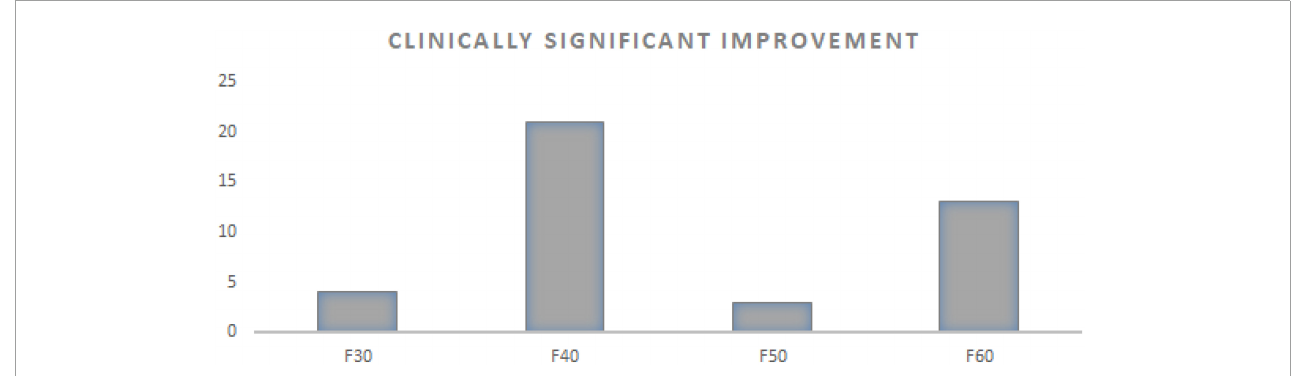
FIGURE2 Number of patients with clinically significant improvement in relation to ICD diagnosis (total number 41/71 patients). F30 F30-F39-mood affective disorders (total number 8). F40 F40-F49-anxiety, dissociative, stress-related, somatoform, and other non-psychotic mental disorders (total number 37). F50 F50-F59-behavioral syndromes associated with physiological disturbances and physical factors (total number 6). F60 F60-F69-disorders of adult personality and behavior (total number